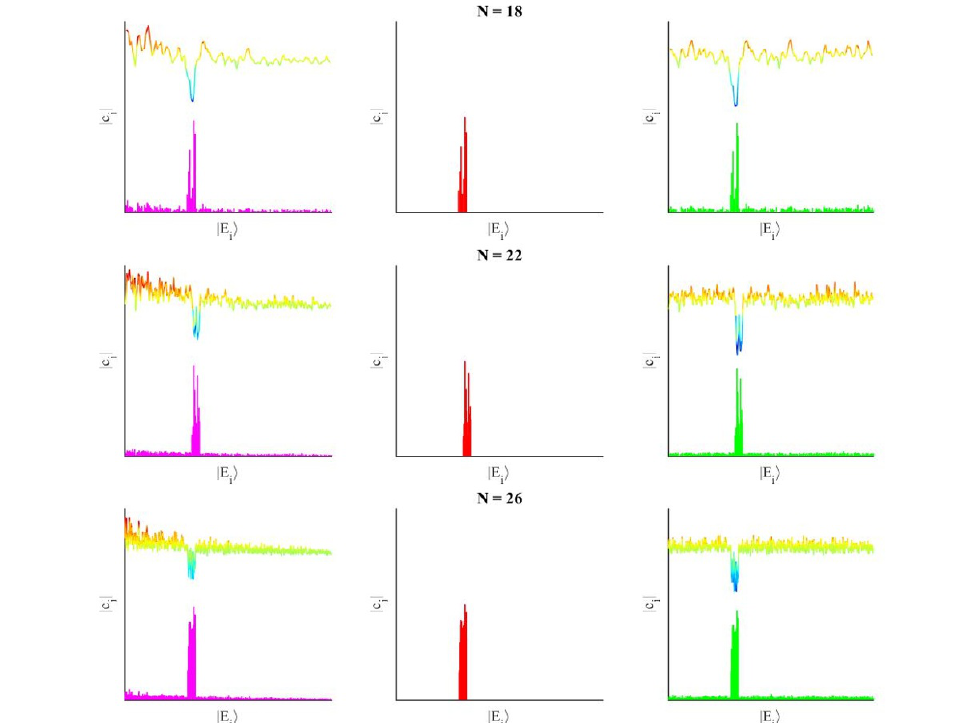
Figure 21 . Distribution of j c i j in non-equilibrium state of the form U ( e S i ) j (cid:9) 0 i (magenta), typical equilibrium state j (cid:9) 0 i (red), and non-equilibrium state of the form U ( S i ) j (cid:9) 0 i (green). The line above the bar plot shows, in heat map colors, which eigenstates are excited, and which ones are suppressed because of the perturbation. Blue eigenstates are suppressed, while eigenstates with other colors are excited with small (green), medium (orange), or large (red) magnitude.